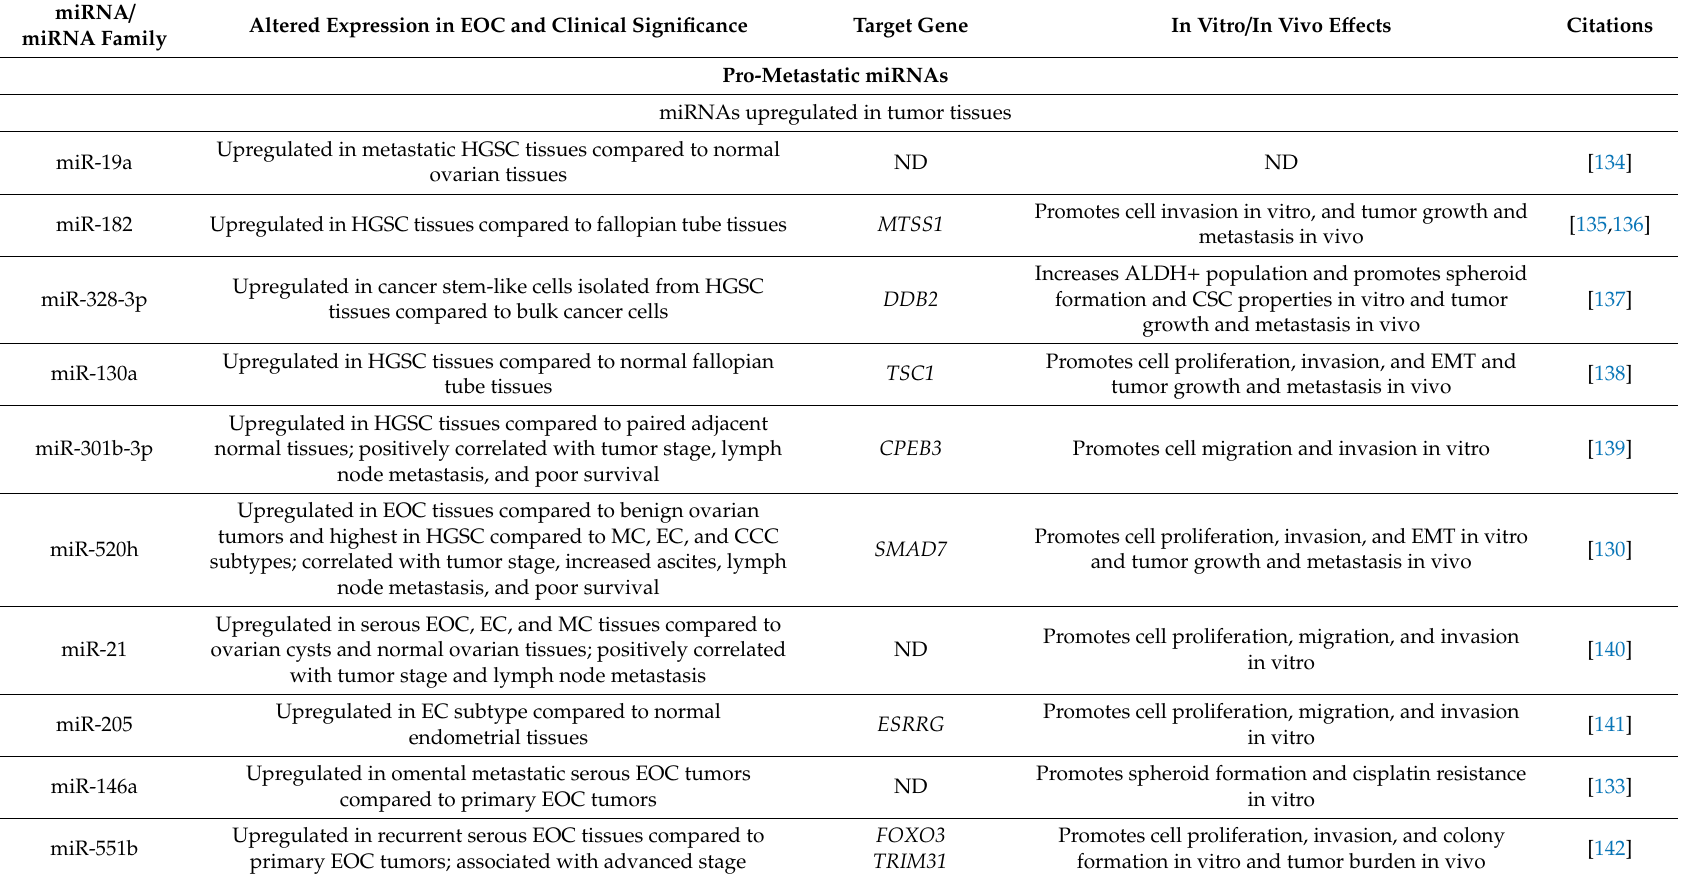
Table 1. Metastasis-related miRNAs in epithelial ovarian cancer